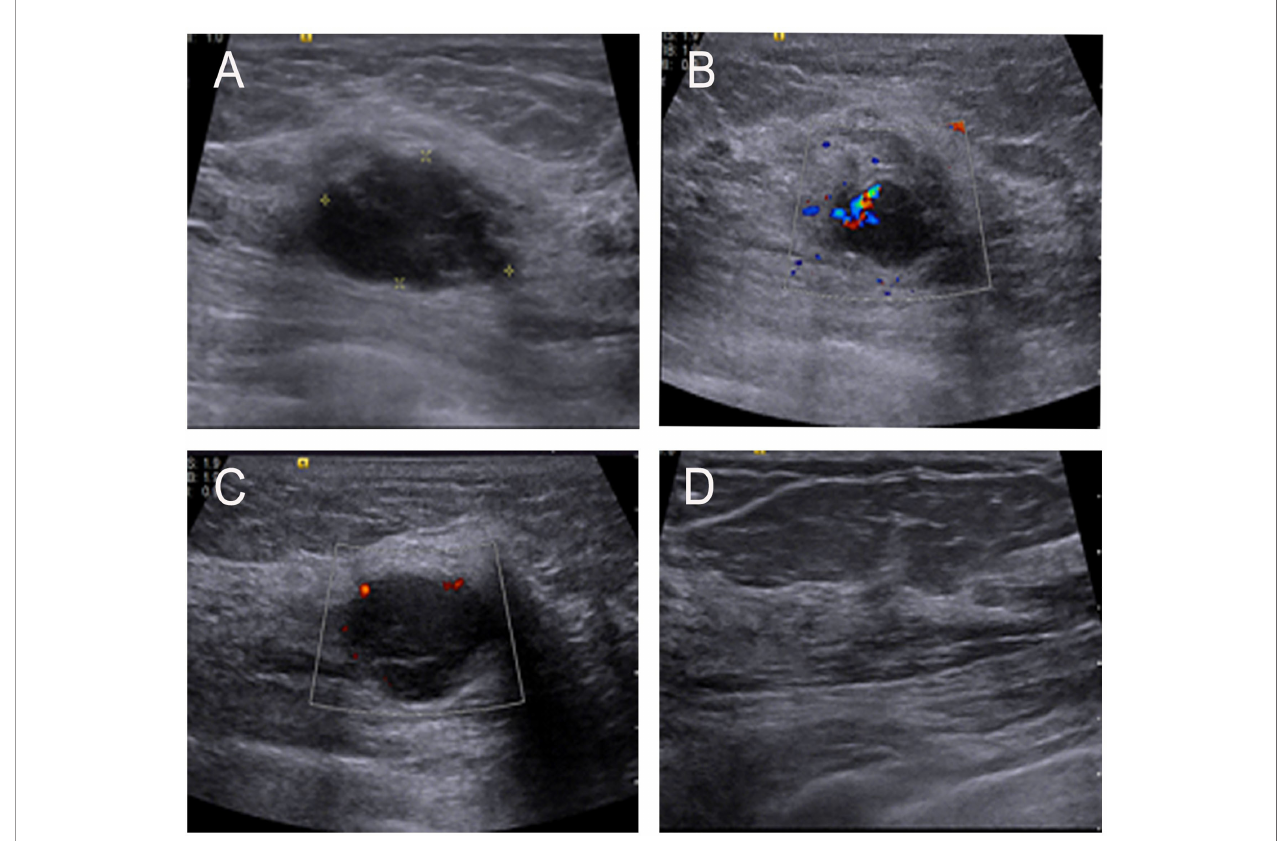
FIGURE 1 | (A) Ultrasonographic image showing a low echo mass in the upper inner quadrant of the left breast and with an irregular shape and uneven internal echogenicity. (B, C) Color- fl ow Doppler image showing small amount of blood fl ow signals inside and vessels in rim. (D) No enlarged lymph nodes were found in the